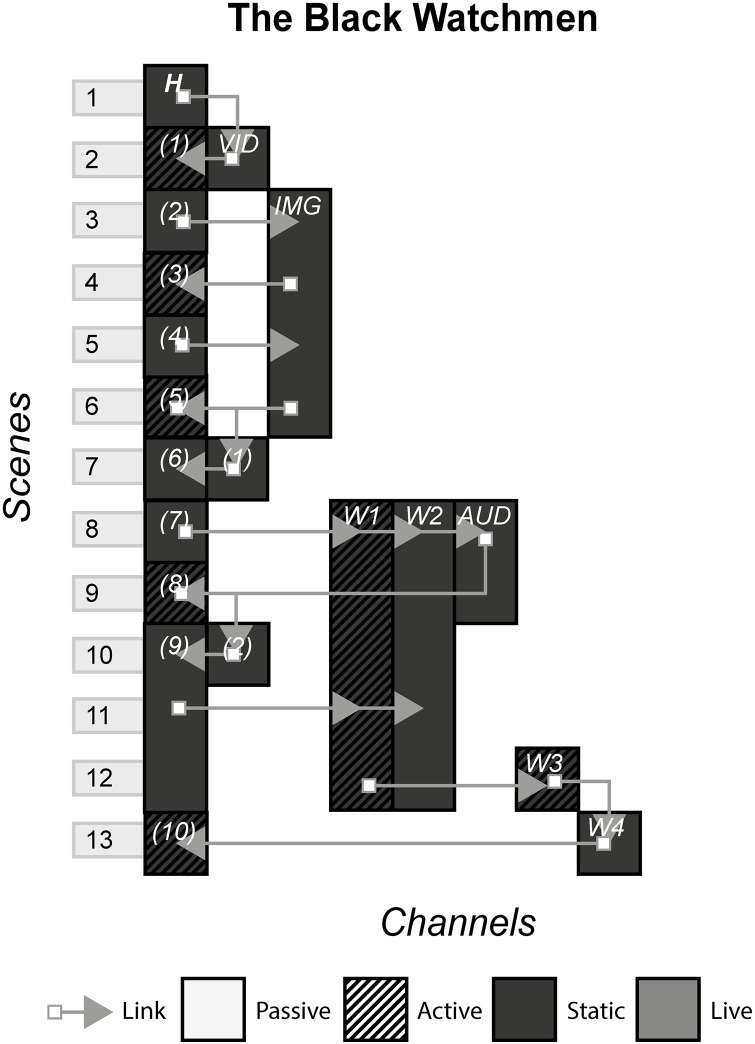
The Black Watchmen.